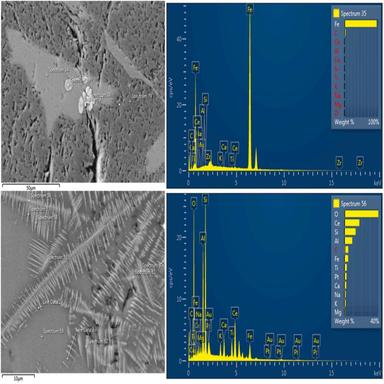
Analysis shows the Elemental Iron billet (top) and the structure of feather (bottom) formed as combination Silica and cerium oxide.